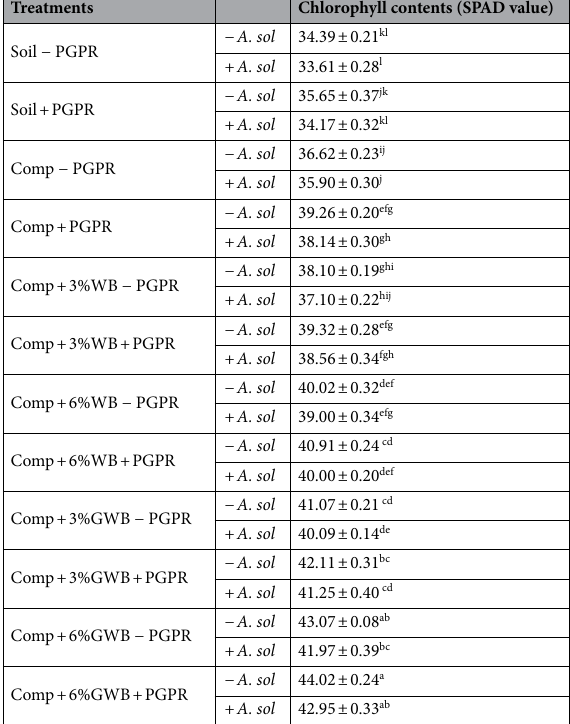
Table 2. Effect of Alternaria solani and PGPR on chlorophyll contents of tomato plants grown in different soil substrate compositions including compost alone and in combination with 3 and 6% of wood biochar (WB) and green waste biochar (GWB). Data were mean values ± standard error (n = 5) followed by different letters in the superscript suggest significant difference as per Tukey’s HSDtest ( P ≤ 0.05). SPAD-502—Soil Plant Analyses Development chlorophyll meter of Konica Minolta company was used.